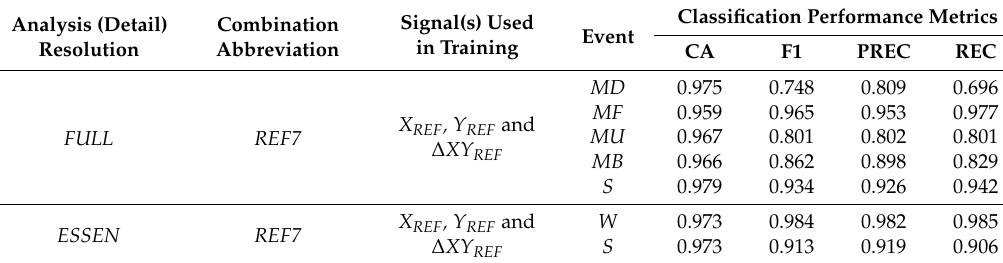
Table 6. Detailed description of the classification performance for the best